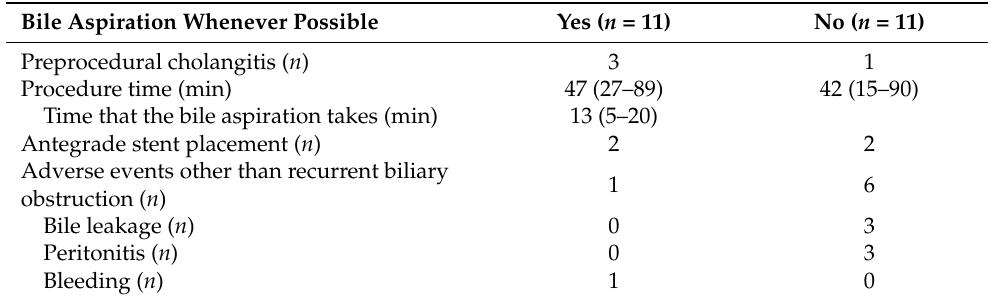
Table 4. Patient characteristics and outcomes with and without bile aspiration whenever possible.